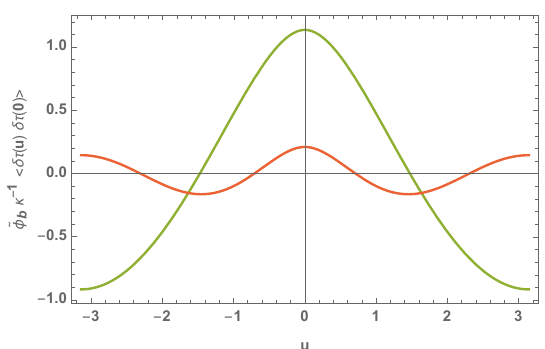
Figure 4 . The propagator in equation (5.16) as a function of u is shown in green. In red, we plot the propagator for the perturbative Schwarzian action resulting near the boundary of the hyperbolic